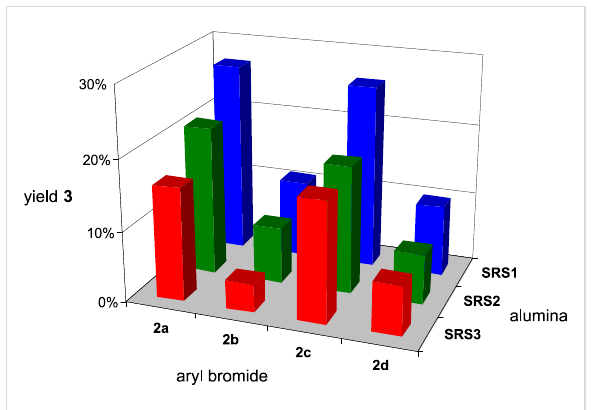
Figure 2: Results of the Suzuki–Miyaura reaction according to Scheme 1 assisted by pure aluminas [5 g SRS1 – 3 : cf. Table 2; ball milling: 2 agate milling beakers ( V = 45 ml), 6 agate milling balls ( d = 15 mm) per beaker, 800 rpm, 10 min; batch: 5 mmol aryl bromide, 124 mol % phenylboronic acid, 3.6 mol % Pd(OAc) 2